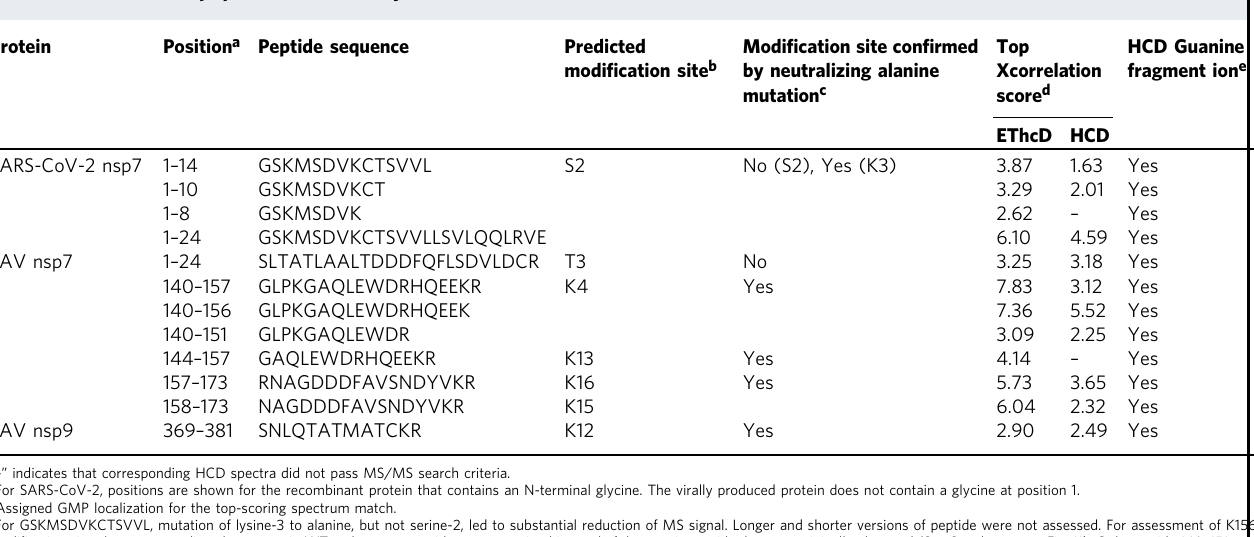
Table 1 GMP-labeled peptides detected by LC –